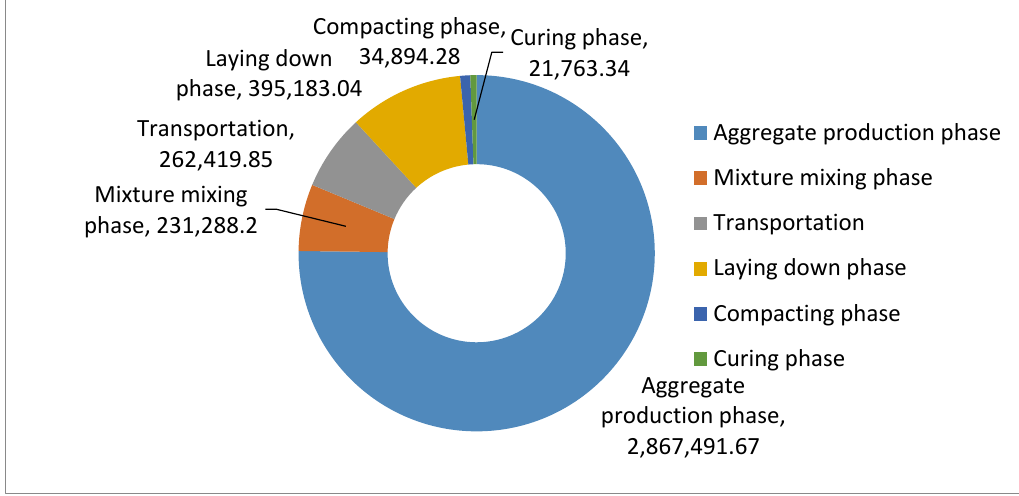
Figure 8. CO 2 e emission of cement-stabilized aggregate course excluding the cement production phase(unit: kg).